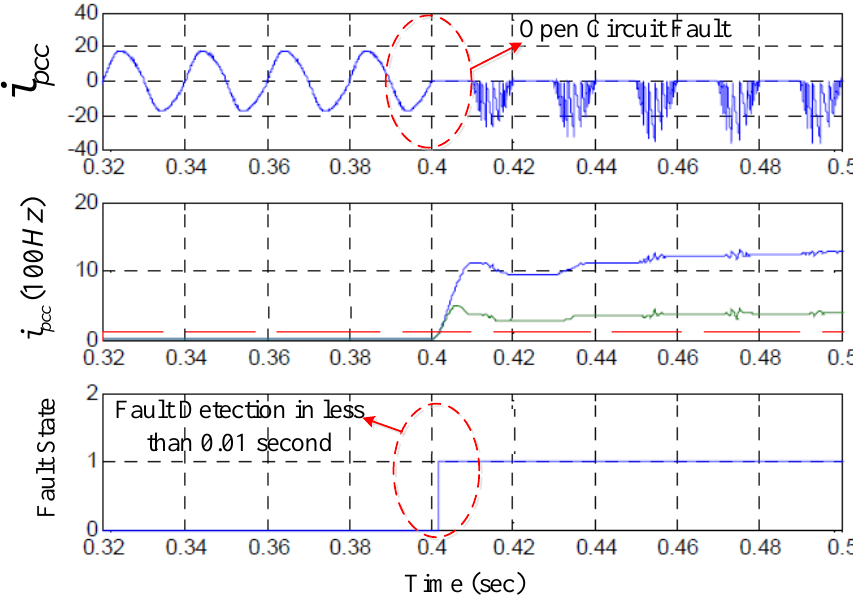
Figure 11. Inverter switch open circuit fault.